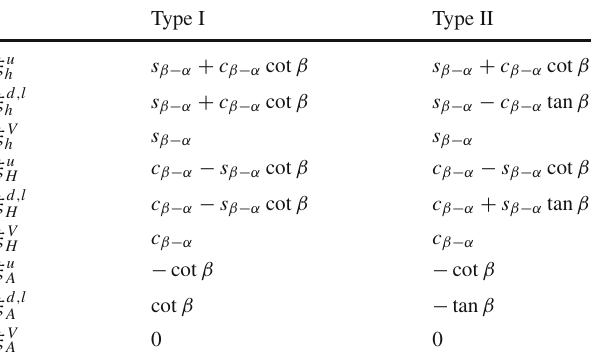
Table 2 Relevant factors appearing in the couplings of the neutral , and to gauge-bosons, ξ V , in the Higgs bosons to fermions, ξ f h , H , A h , H , A 2HDM of type I and type II Type I Type